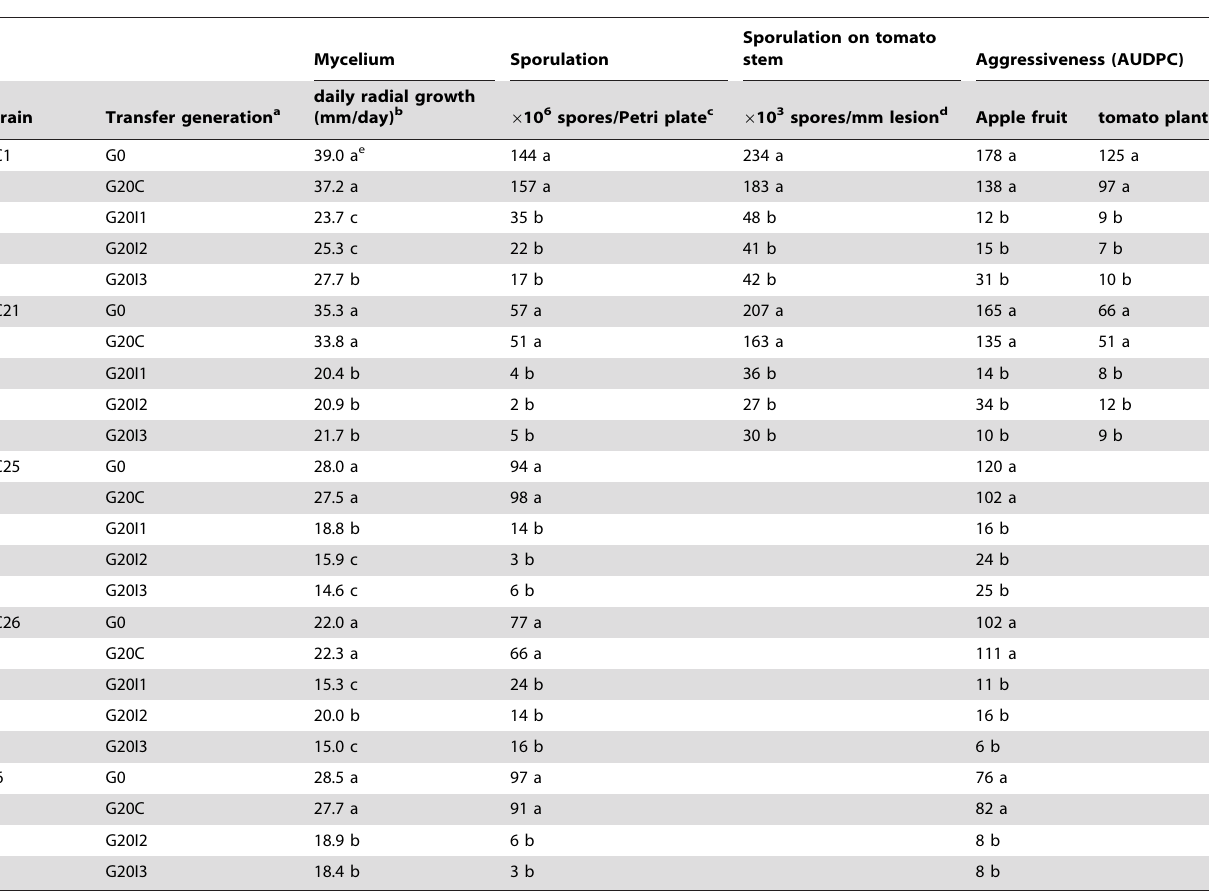
Table 2. Comparison of fitness parameters between the iprodione-induced mutants and the parental